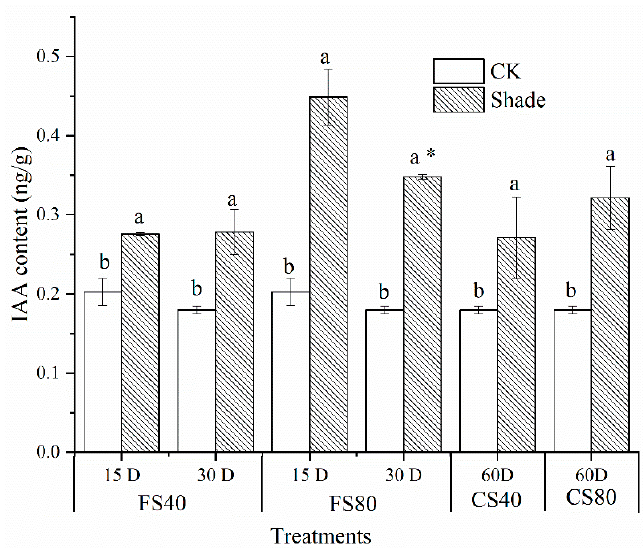
Figure 2. E ff ects of shade stress on indole-3-acetic acid contents in peanut leaves. Data represent mean ± standard error from three experimental replicates, each with three plants. The indole-3-acetic acid (IAA) was measured in leaves on the main stem after 40% and 80% shading for 15 days, 30 days at the flowering stage (FS), and shading from the seeding stage for 30 days to the flowering stage for another 30 days (CS). The IAA content was calculated as ng per gram fresh leaf weight. Letters a and b after the value represent the statistically significant di ff erence ( p < 0.05) between any two conditions within a stage as determined by the Least Significant Di ff erence test. * represents a significant di ff erence ( p < 0.05) between di ff erent treating durations of 15 days and 30 days. D for days, CK for control under natural sunlight at the same time point.